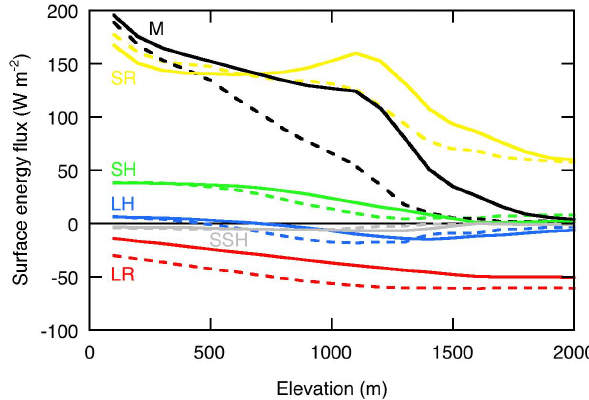
Fig. 5. Measured surface height change due to accumulation and ablation at the weather stations (black), and modelled values within the corresponding elevation bin (colours), with (solid) and without (dashed) MODIS albedo correction. N.B.: for late 2010, measured and modelled data series have been aligned after data gaps.